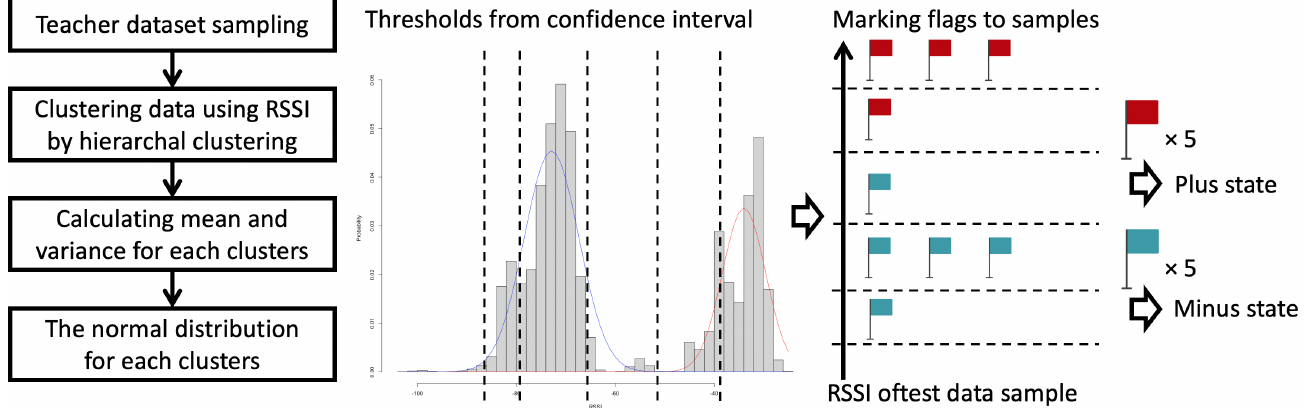
Figure 7. Overview of status estimation method.